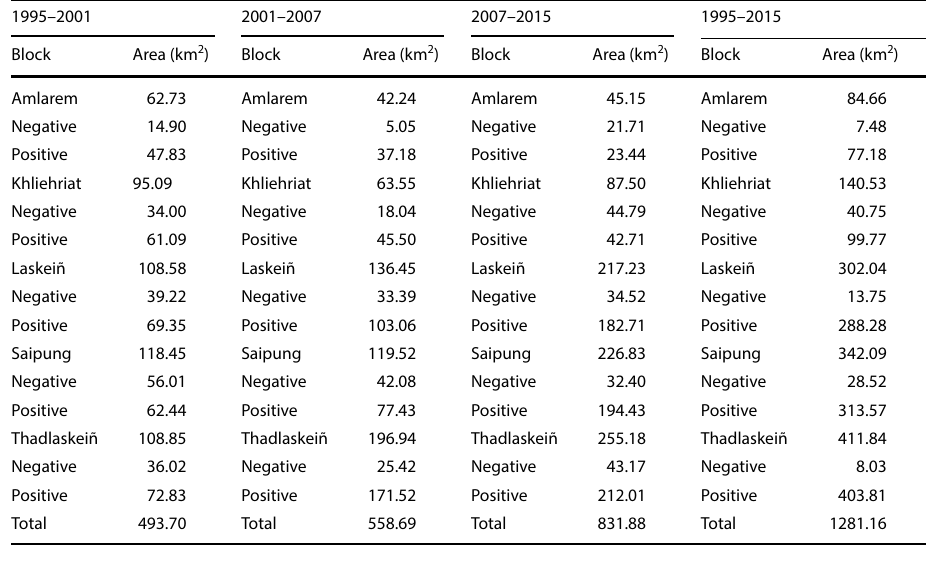
Table 7 Analysis of change area according to the block boundary